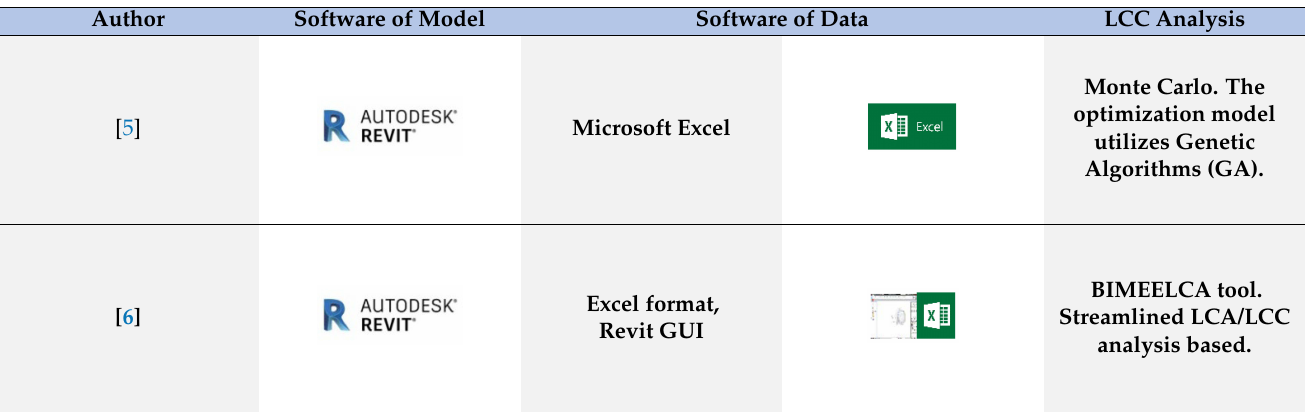
Table 4. Overview of the software used for the integration of BIM on